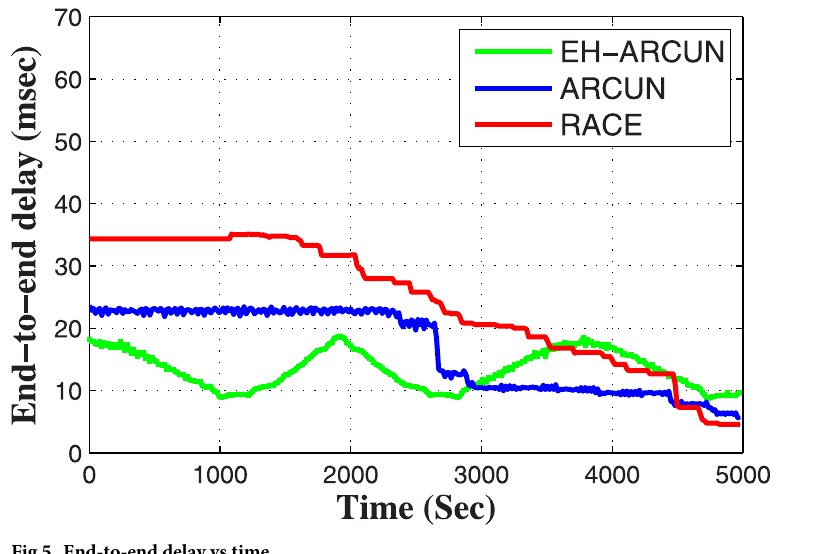
Fig 5. End-to-end delay vs